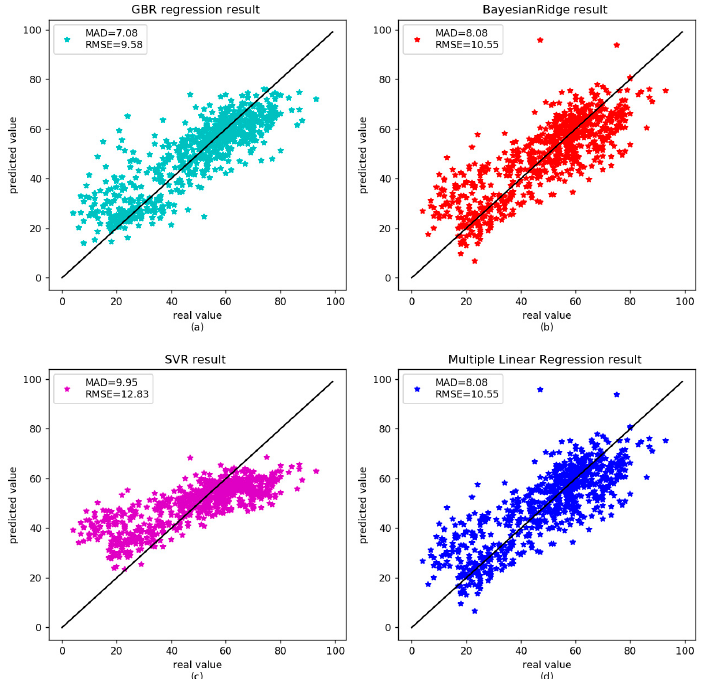
Figure 4. Comparison between the real age and the age predicted by the four models in the validation dataset of disease data.